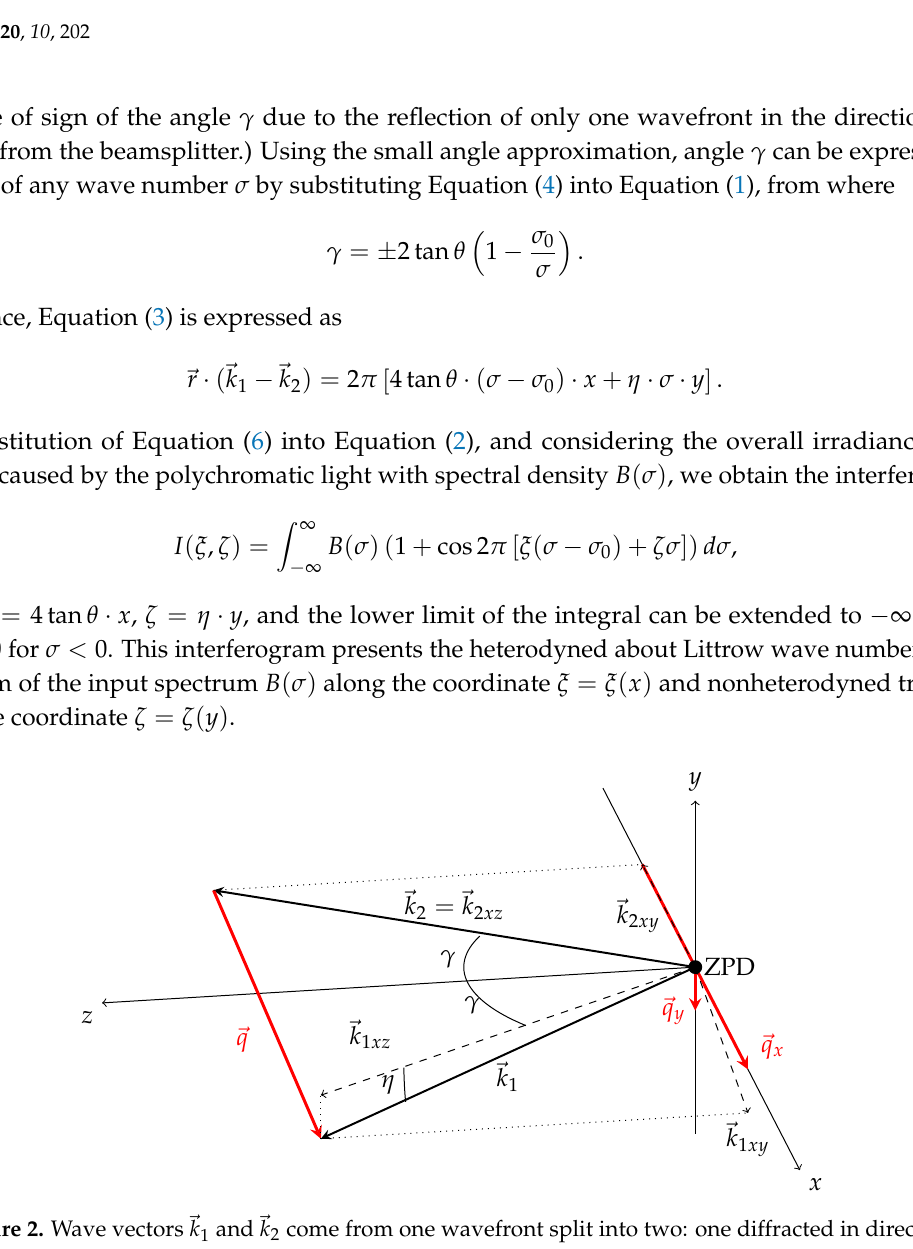
Figure 2. Wave vectors (cid:126) k 1 and (cid:126) k 2 come from one wavefront split into two: one diffracted in direction ± γ with respect to the optical axis z , the other has its projection on the plane xz propagating in the direction ∓ γ . Axis y is parallel to the grooves of the nontilted grating G 2 . Angle η is the tilt given to grating G 1 . Vectors are decomposed on the nonorthogonal basis formed by the projections of the vectors on the coordinate planes, and—for the sake of simplicity—only some of these components (e.g., k 1 xz or k 1 xy ) are shown. Vector components (cid:126) q x and (cid:126) q y are obtained from the difference of